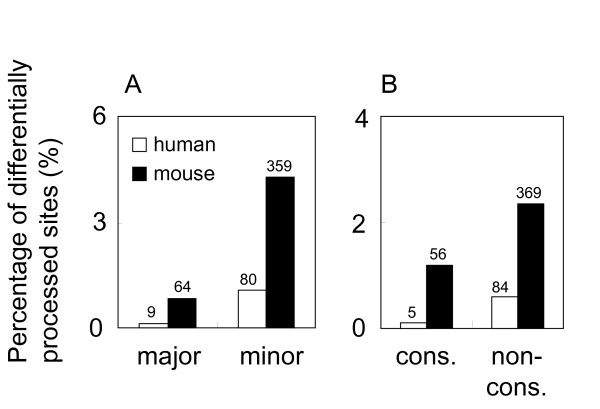
Distribution of differentially-processed polyadenylation sites. (A) Ratio of differentially-processed sites (P < 0.05, Fisher's exact test with Bonferroni correction) against total sites, for human (white) and mouse (black) genes, shown for major and minor sites. (B) Ratio of differentially-processed sites (P < 0.05, Fisher's exact test with Bonferroni correction) against total sites, shown for conserved and non-conserved sites. Value above each bar show absolute numbers of differentially-processed sites.